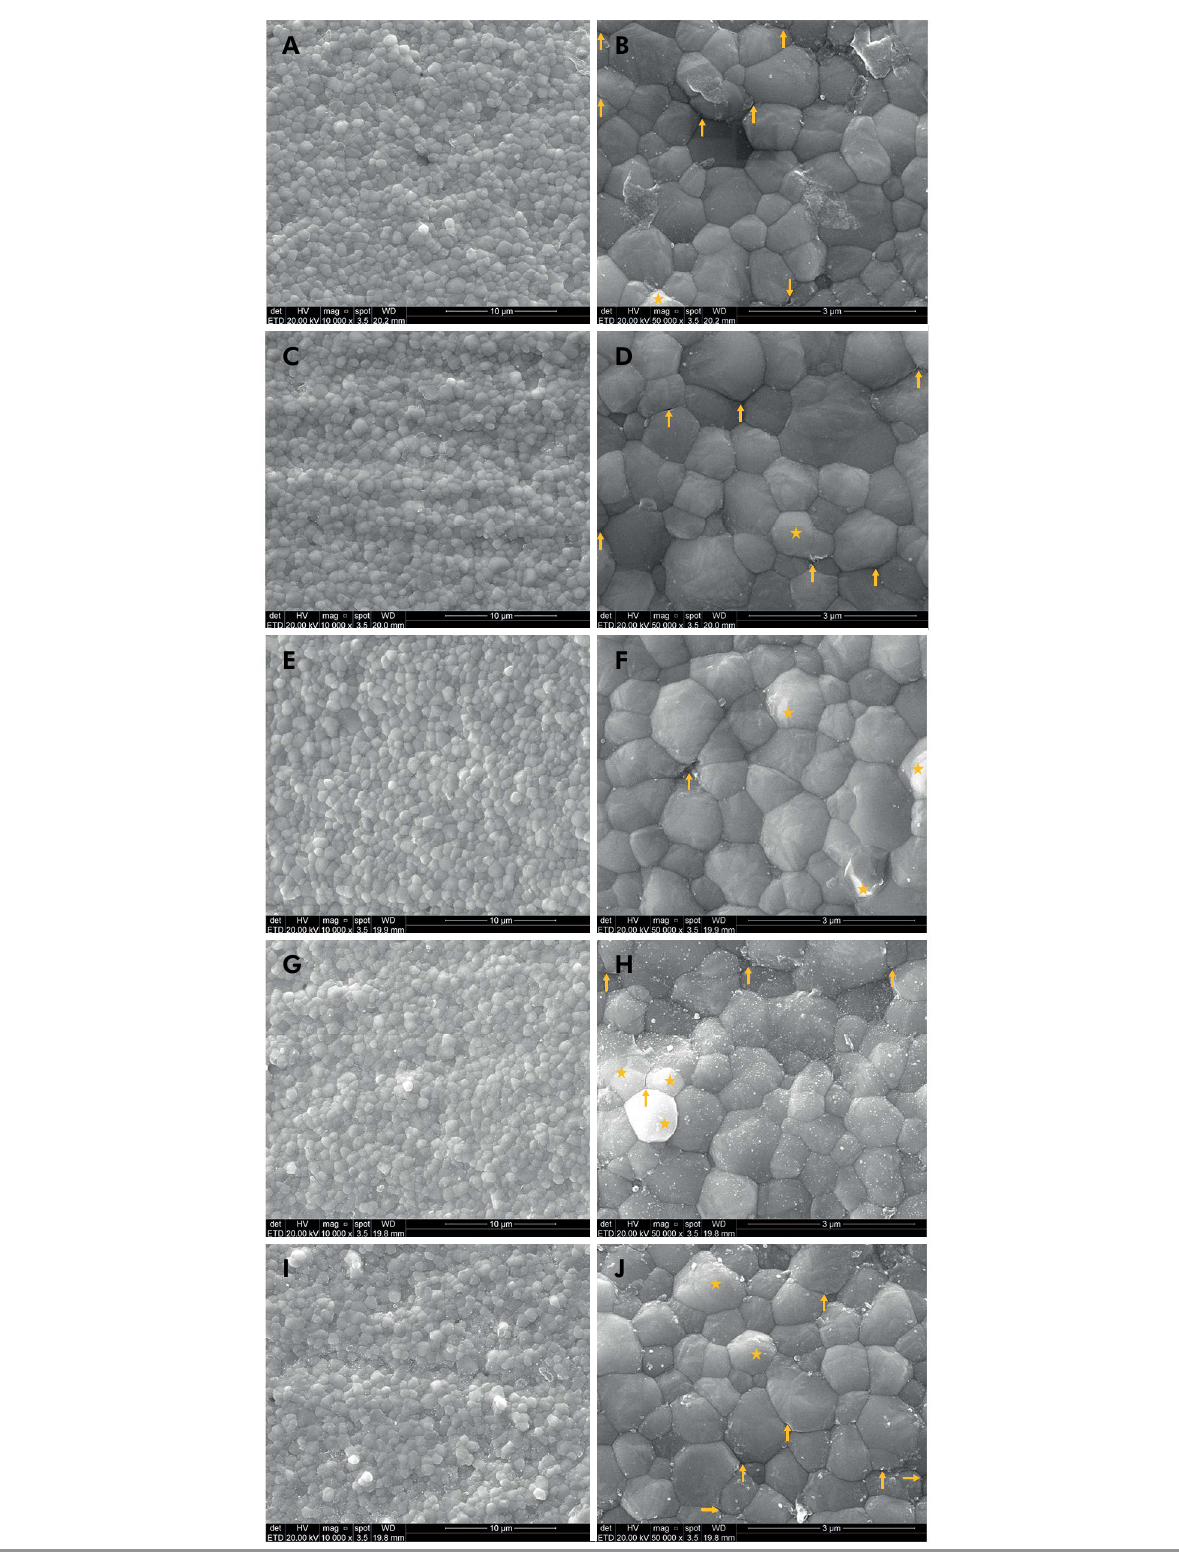
Figure 2. FE-SEM images (10,000x and 50,000x magnifications) of Y-TZP surface, demonstrating that no significant topographical alterations occurred after aging treatments. Yellow stars point to uplifted grains, and yellow arrows indicate intergranular micro- cracks. A and B - CTRL group, C and D - AUT, E and F - MechLoad, G and H - AUT+MechLoad, I and J - STO.